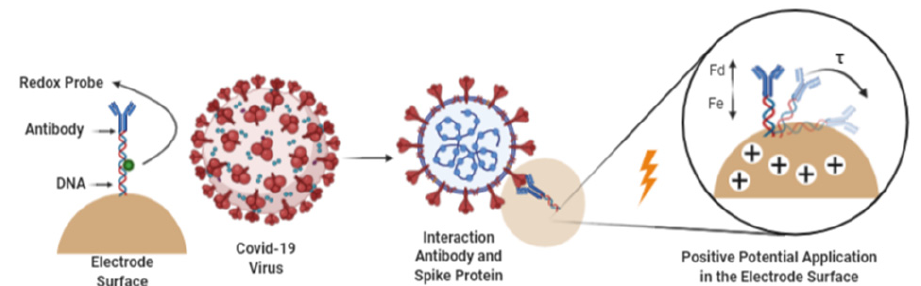
Figure 1. Use of standard biosensors with transducer and signal amplification for data processing.